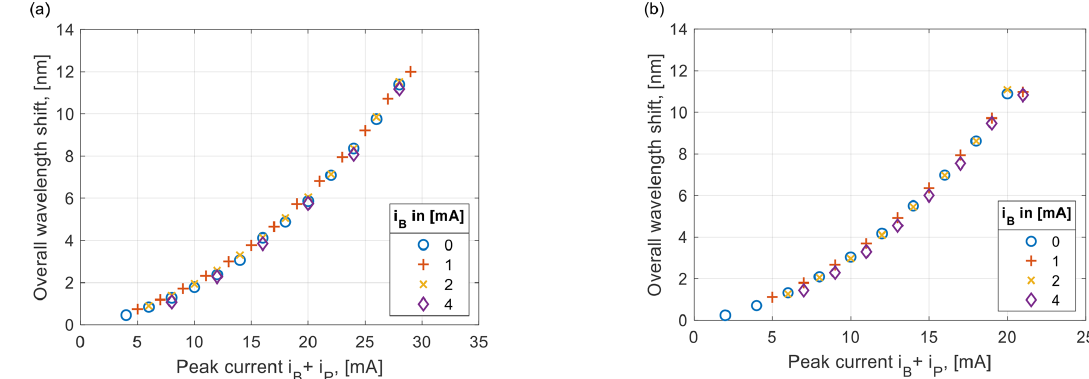
Figure 8. Overall spectral shift within 12µs pulse for (a) VCSEL VL-1544 and (b) VL-1577 as a function of the peak current.